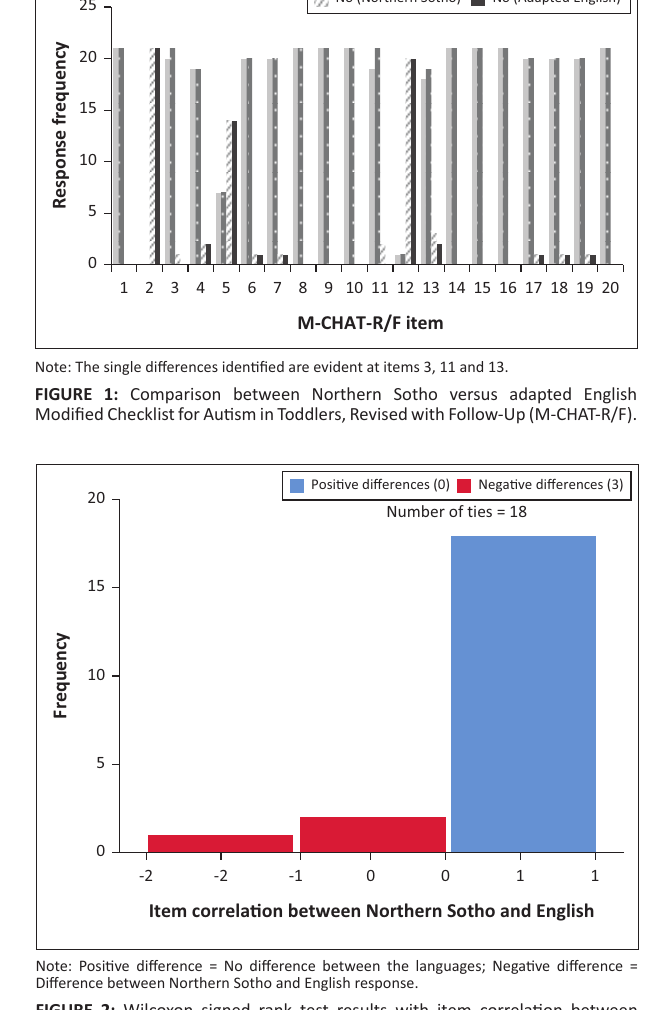
FIGURE 2 : Wilcoxon signed rank test results with item correlation between English adapted version and Northern Sotho version of the Modified Checklist for Autism in Toddlers, Revised with